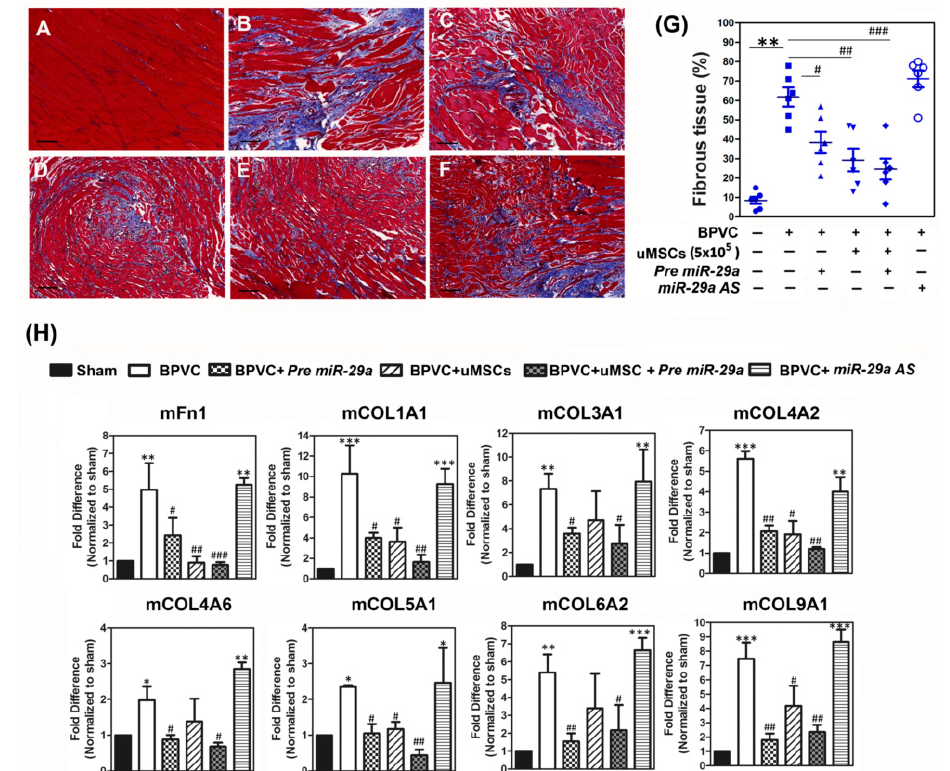
Figure 5. Administration of miR-29a or transplantation of uMSCs exhibited the anti-fibrotic properties of C57BL/6 mice in vivo and alleviated BPVC-induced gastrocnemius muscle fibrosis. ( A – F ) Representative immunohistochemistry figures of gastrocnemius muscles with the nuclei stained black, the muscle cells stained red, and fibrous tissue stained blue by Masson’s trichrome staining, after 3 weeks of ( A ) saline-injection, ( B ) BPVC-injection, ( C ) Pre miR-29a administration, ( D ) uMSCs transplantation, ( E ) combination of Pre miR-29a and uMSCs treatments, or ( F ) BPVC + miR-29a AS administration. At least five different tissue sections randomly selected from each group of mice were estimated and their expression patterns were similar ( n = 6/each group). Scale bar: 100 µm. ( G ) After 21 days of uMSCs transplantation, the amount of fibrotic tissues was scored by Masson’s trichrome staining. The level of fibrosis was significantly abridged post 21 day–s of Pre miR-29a administration or uMSCs transplantation, and shown maximal reduced effect by combination of Pre miR-29a and uMSCs treatments. ( H ) Tissue extracts were collected from gastrocnemius muscles on day 21 post saline or BPVC injections, or after three weeks of Pre miR-29a , miR-29a AS as well as uMSC transplantation post 72 h of BPVC-injection. The protein levels of extracellular matrix (ECM) genes in each group of mice were estimated by using the Quantibody Mouse ECM Array ( n = 6/group). Data were shown in means ± SD; * p < 0.05, ** p < 0.01, *** p < 0.001 for the BPVC group vs. the Sham group; # p < 0.05, ## p < 0.01, and ### p < 0.001 for the BPVC group vs. the Sham group; * p < 0.05, and ** p < 0.01 for the BPVC + Pre miR-29a group, the BPVC + miR-29a AS group, the BPVC + uMSC group, the BPVC + uMSC + Pre miR-29a group vs. the BPVC group.